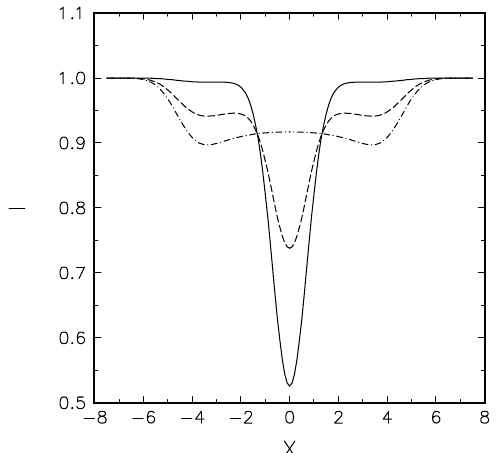
Figure 3. Photospheric line broadening in the T Tauri type star (solid line) during an eclipse due to scattering at the inner boundary of the protoplanetary disk. The dot-dashed line corresponds to the total eclipse.